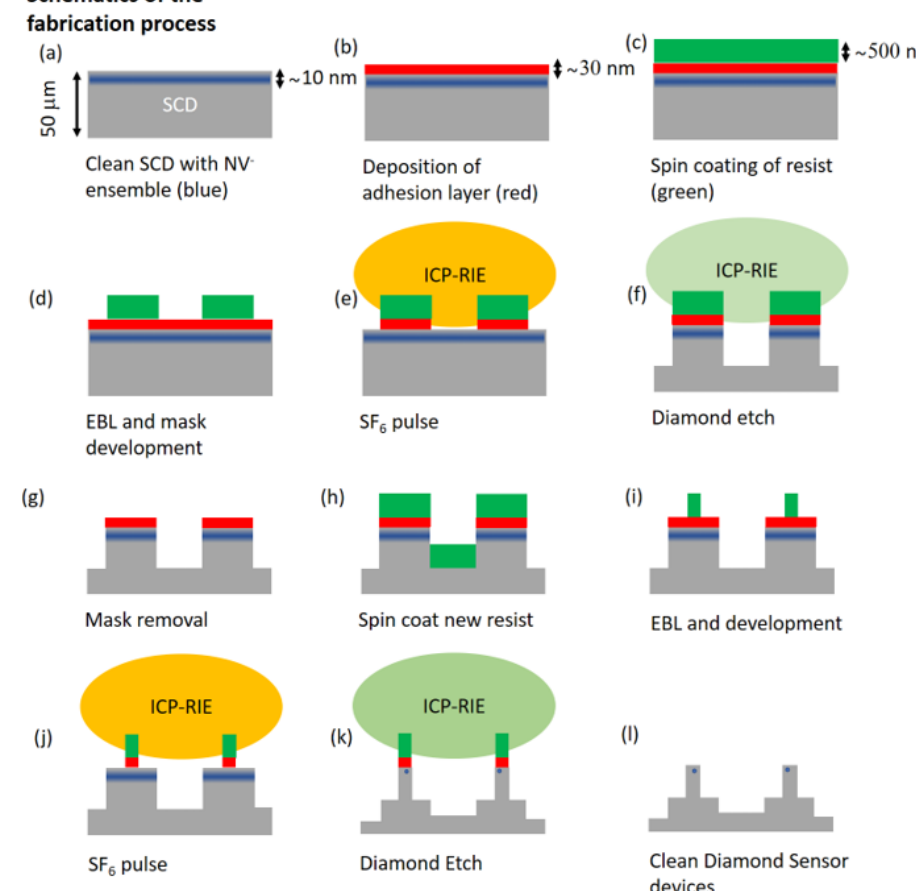
Figure 1. ( a ) The process starts with an SCD sample with a shallow layer of NV centers. Subsequently, we deposit ( b ) a silicon adhesion layer and ( c ) spin coat HSQ. ( d ) We use electron beam lithography (EBL) to structure the HSQ resist and obtain masks for the platforms. Using ICP-RIE, ( e ) we remove the silicon layer in-between the HSQ mask and ( f ) perform the structuring etch for SCD. ( g ) We finalize platform structuring via removing residual HSQ. We now ( h ) spin coat HSQ onto the remaining silicon layer and ( i ) perform EBL again. We repeat the ICP-RIE procedure, firstly ( j ) removing the silicon layer and then ( k ) etching the pillars into SCD. In a last step, ( l ) we remove residual HSQ as well as silicon